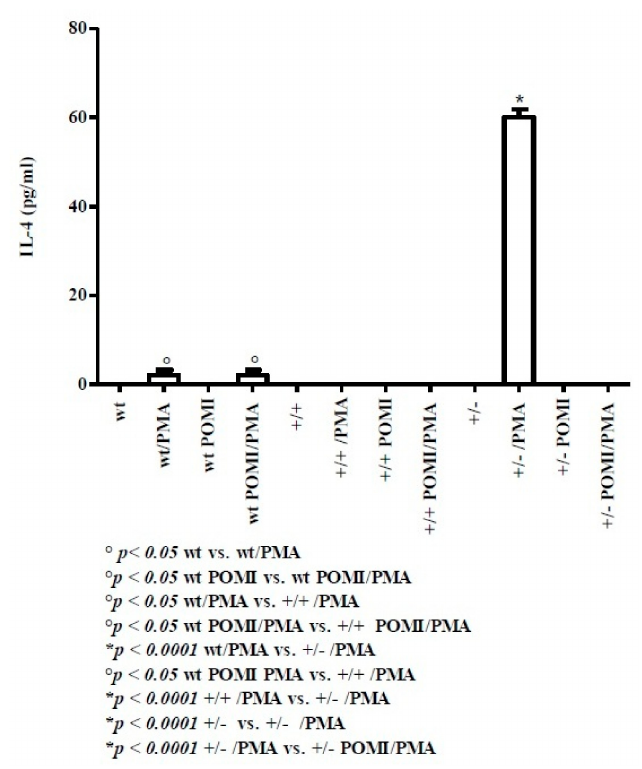
Figure 4. Levels of IL-4 in splenic supernatants from cell cultures of mice at day 30. For methods, abbreviations, and statistical analysis, see Figures 1 and 2.